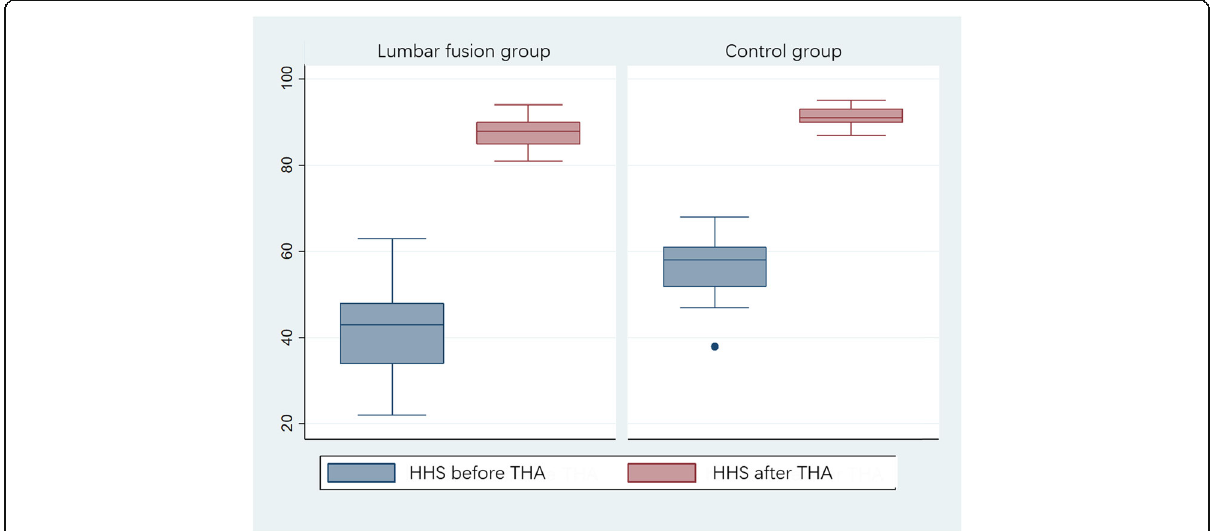
Fig. 4 The box plot of the Harris hip score showing that the score was significantly improved after THA in both the lumbar fusion and control